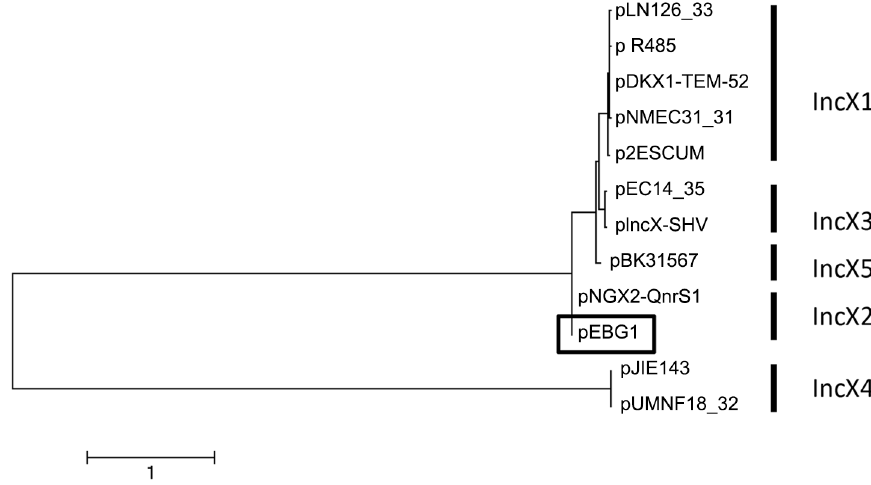
Figure 1. a. Maximum likelihood dendogram depicting evolutionary relationships among TaxC sequences from 12 IncX plasmids, including representatives from groups defined from whole plasmid polymorphisms [20] and pEBG1(boxed), the plasmid sequenced in this study.